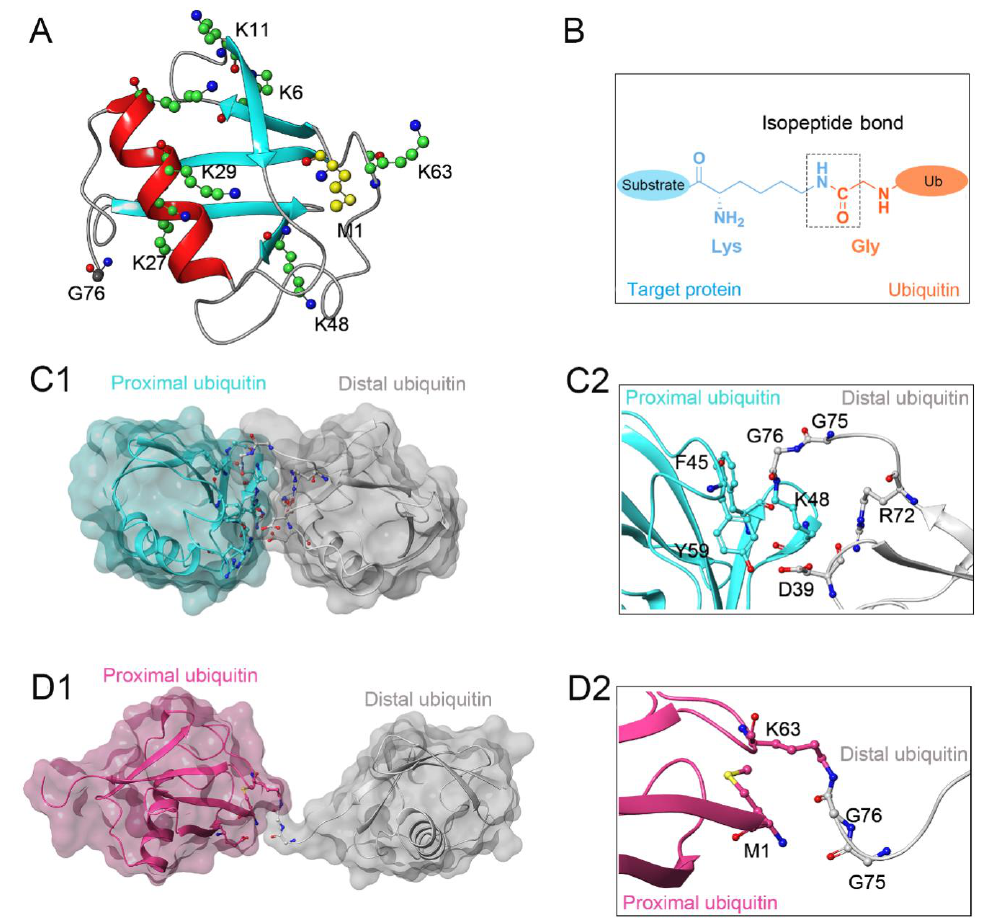
Figure 1. ( A ) Crystal structure of human ubiquitin (PDB ID: 1UBQ). Seven lysine residues and an N-terminal methionine residue are colored green and yellow, respectively. ( B ) The isopeptide bond between the ubiquitin glycine residue (orange) and the target protein lysine residue (blue). ( C1 , C2 ) The overall structure and local conformation of K48-linked polyubiquitin chains (PDB ID: 1TBE). ( D1 , D2 ) The overall structure and local conformation of K63-linked polyubiquitin chains (PDB ID: 3HM3). The distal and proximal ubiquitin are colored gray and cyan, respectively. To date, the human genome encodes nearly 600 E3 ligases while only approximately 100 deubiquitinating enzymes (DUBs) have been identified, clustered in the following 7 families: 56 ubiquitin-specific peptidases (USPs), 17 ovarian tumor proteases (OTUs), 12 JAB1/MPN/Mov34 metalloenzymes (JAMMs), 5 motif interacting with ubiquitin-contain- ing novel DUB family proteases (MINDYs), 4 ubiquitin C-terminal hydroxylases (UCHs),